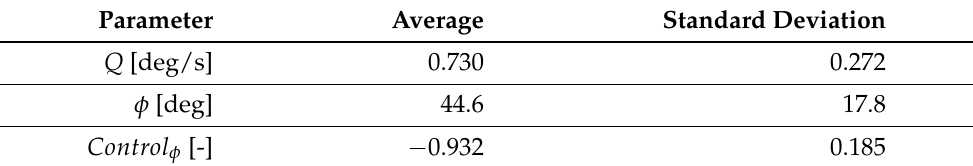
Table 4. Averages of the maximum values in all the 246 flight datasets for the thresholds.